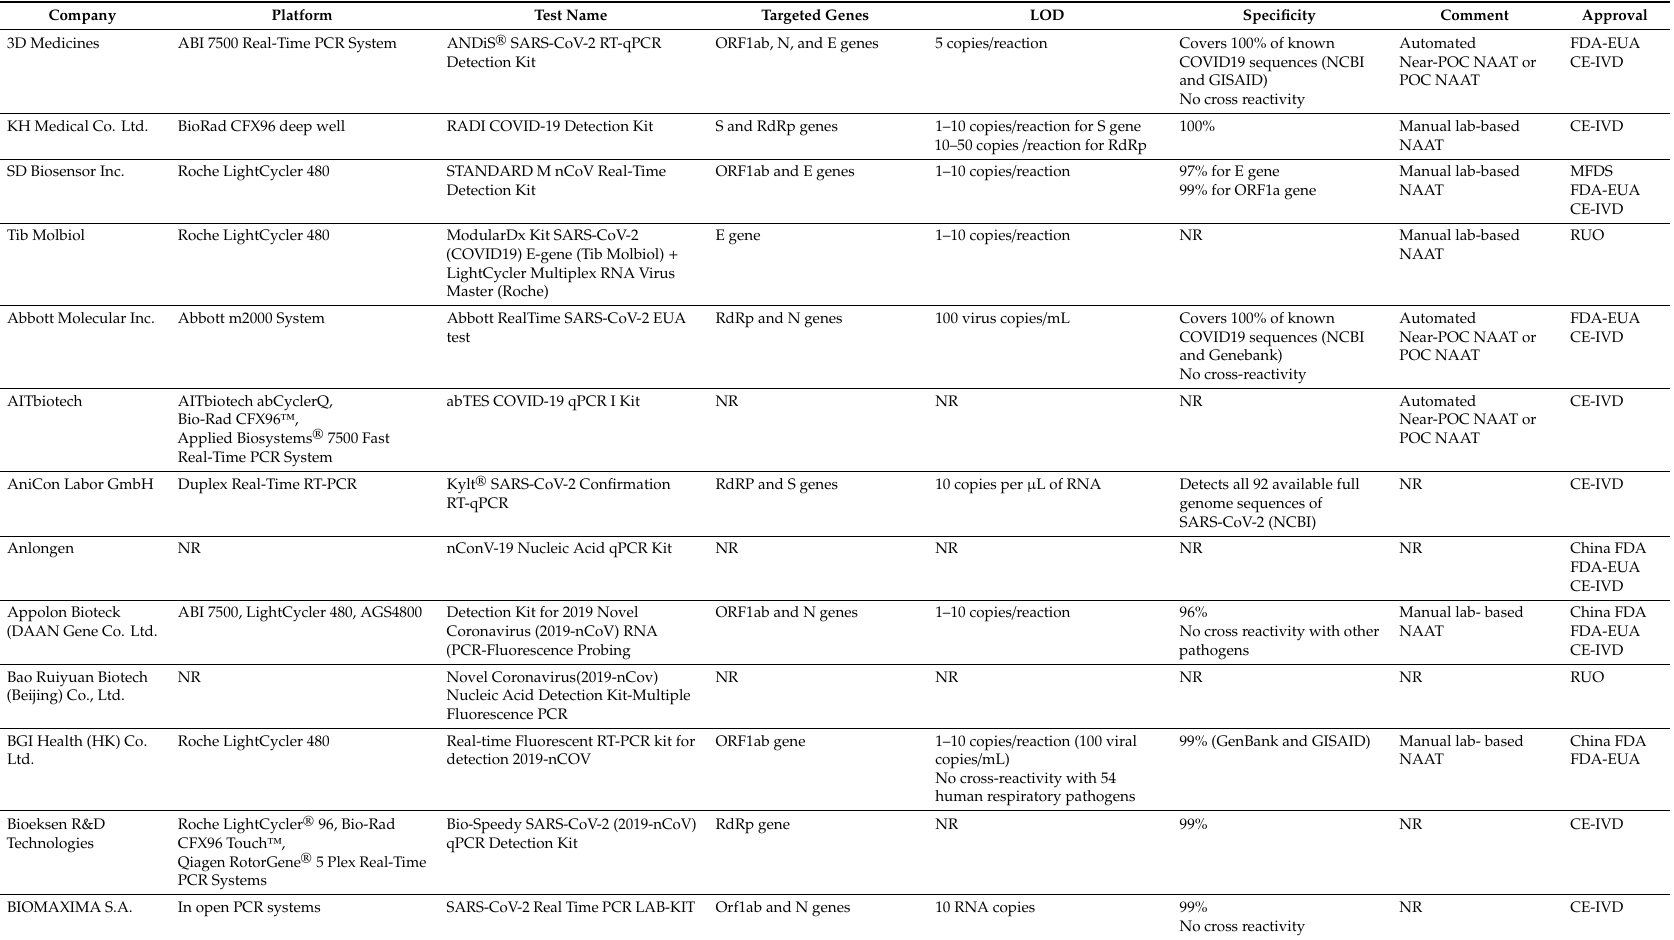
Table A1. Specifications of the available polymerase chain reaction (PCR) commercial kits for laboratory diagnosis of